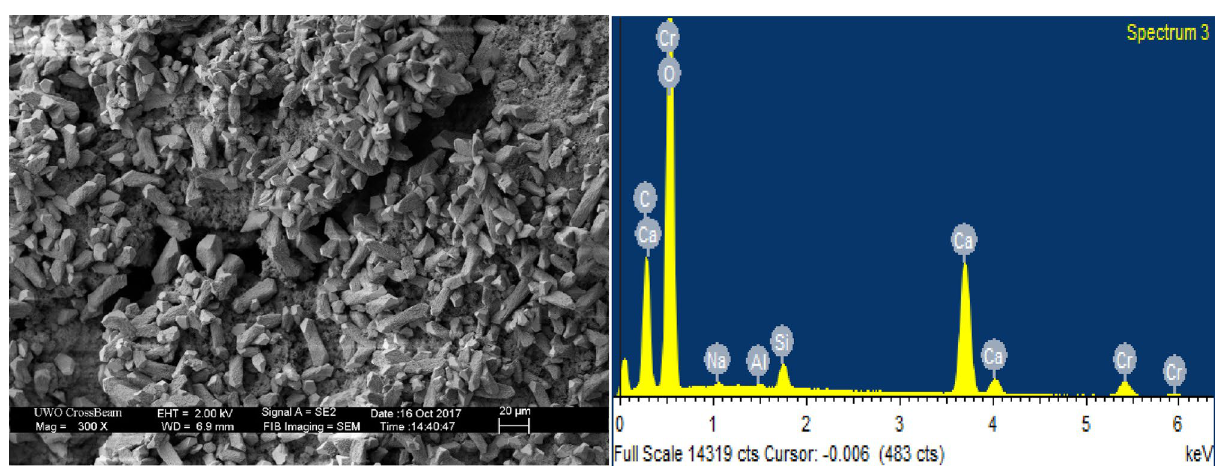
Figure 9. SEM micrograph with EDX pattern of products in self-healed cracks of CC8